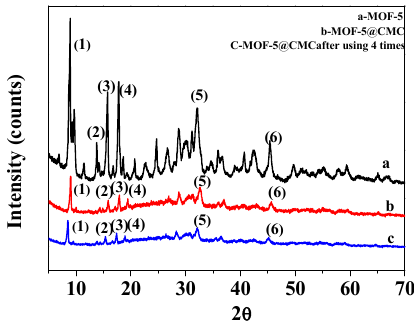
Figure 3. X-ray diffraction (XRD) patterns for (a) MOF-5, (b) MOF-5–CMC and (c) MOF-5–CMC after 4 uses.